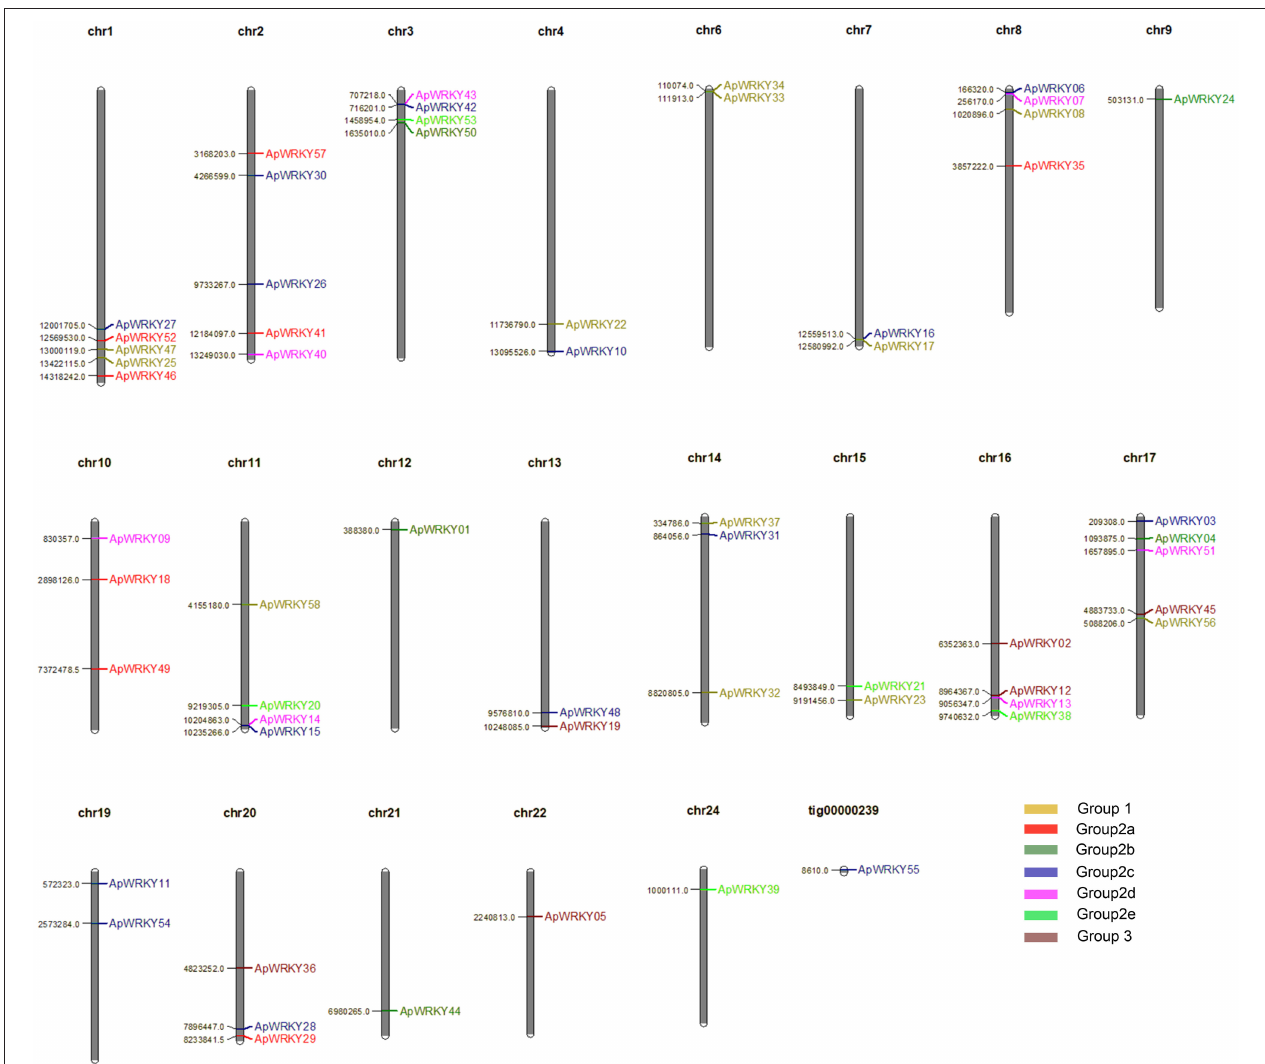
FIGURE 1 | Distribution of 58 WRKY genes on the 21 Chuanxinlian chromosomes and one tig. Different group members are presented in various colors: yellow, Group 1; red, Group 2a; dark green, Group 2b; blue, Group 2c; pink, Group 2d; light green, Group 2e; brown, Group